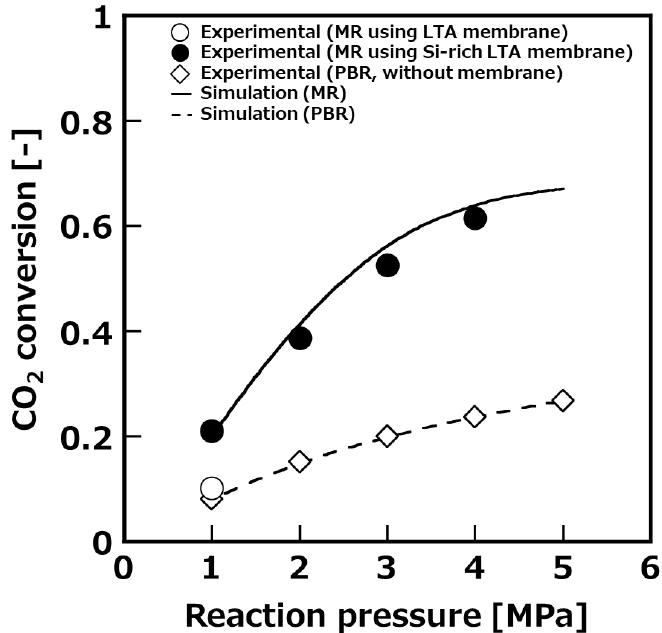
Figure 5. Pressure dependence of CO 2 conversion to compare with membrane reactor (MR) and packed-bed reactor (PBR) (SV = 200 h − 1 ).